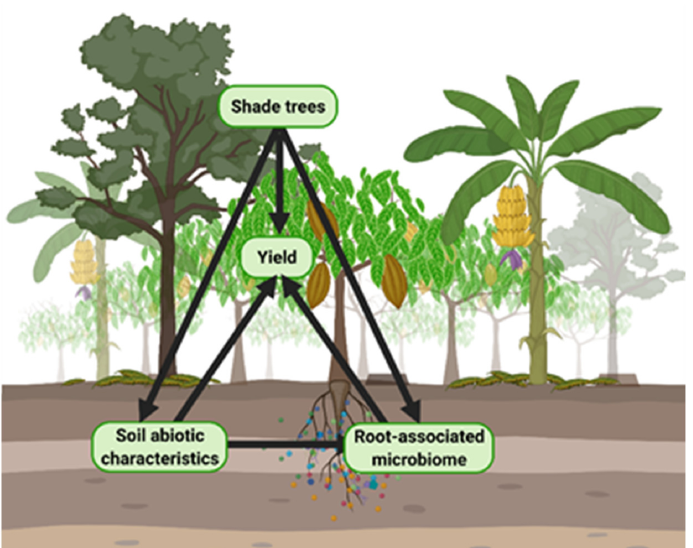
Figure 1. Hypothesized relationships of shade trees, soil physicochemical properties, root-associated microbial communities, and yields in cacao agroforestry systems. Shade trees are predicted to directly impact yields by altering microclimatic conditions and available photosynthetically active radiation, and impact soil properties and microbial communities via litter inputs and rhizosphere effects. Both yields and microbial communities are expected to respond to nutrient availability and other soil abiotic characteristics. Beneficial and pathogenic microorganisms are expected to increase and decrease cacao yields,